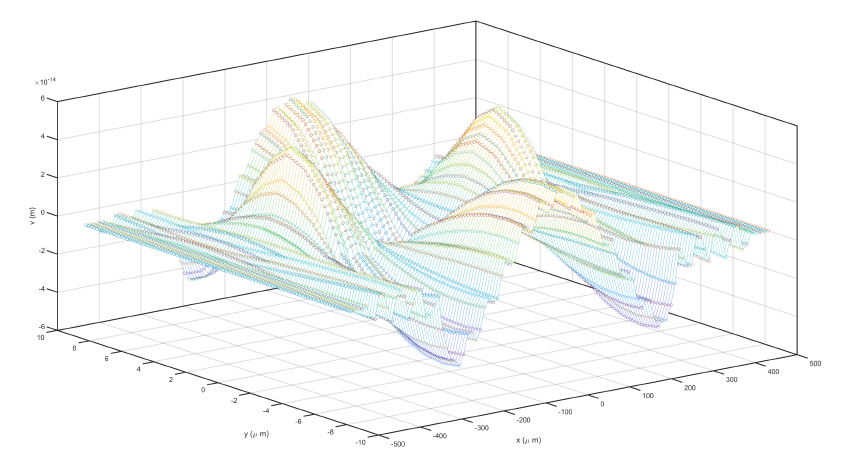
Figure 12. Horizontal displacement of mode 2.